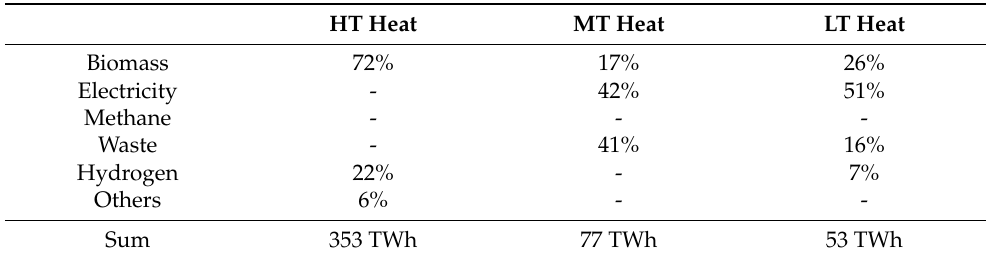
Table 1. Process heat (excluding steel and cement industry) in 2050 [67]. HT (high-temperature); MT (mid-temperature); LT (low-temperature). HT Heat MT Heat LT Heat Biomass 72%